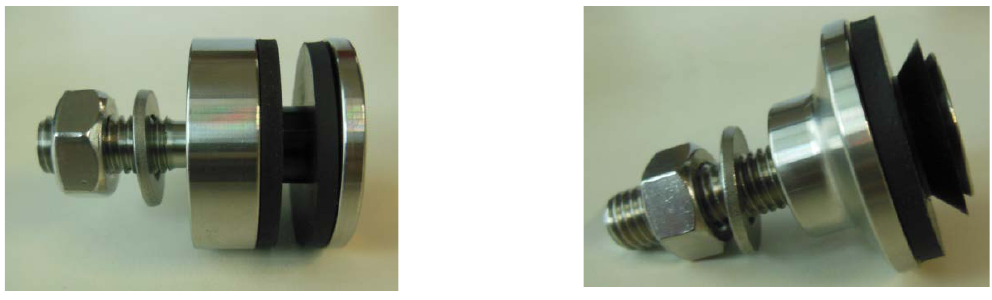
Fig. 4 Plate holders (left) and countersunk holders